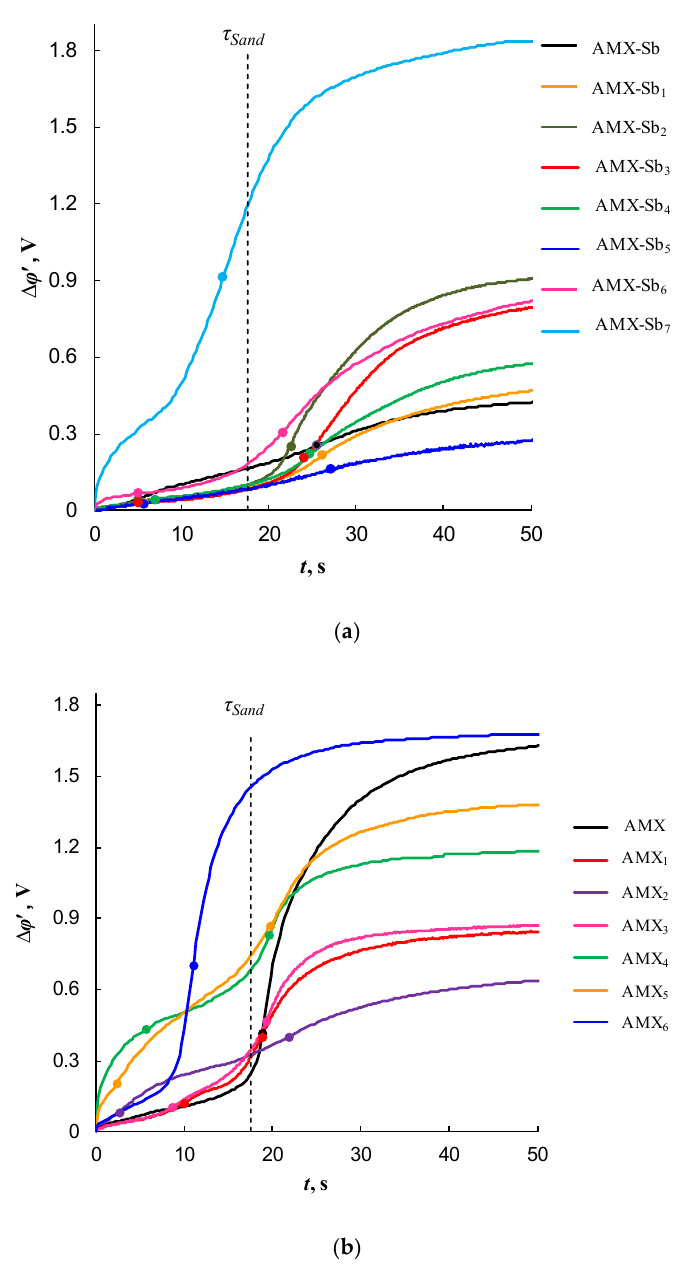
Figure 8. Chronopotentiograms in the cases of pristine and modified AMX-Sb ( a ), and AMX ( b ) membranes measured at i = 1.4 i th . The circles show the inflection points related to τ 1 and τ 2 ; the lim vertical dashed line shows τ Sand (Supplementary